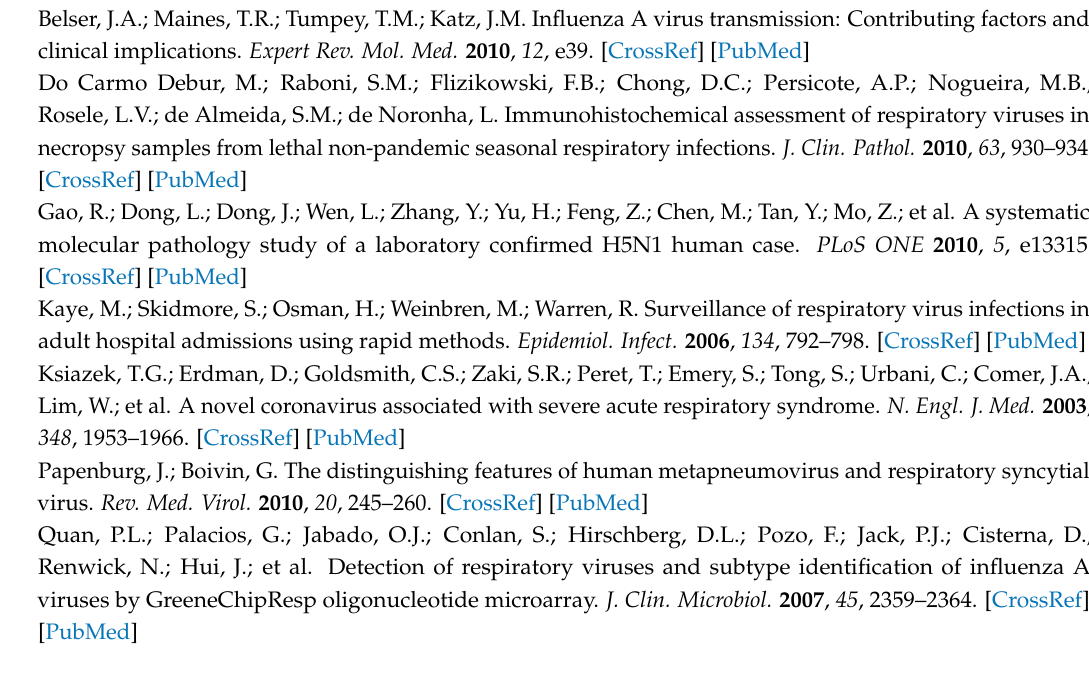
Table S1: Proteomics identification of proteins in murine BAL fluid from MHV-68 infection, Table S2. RT-PCR primers used in this study, Figure S1. Analysis of viral and cellular components in BAL fluid. Figure S2. One of the LC/MS-MS spectra identifying mouse Pdx6. Figure S3. Dynamics of ROS generation in MHV-68 infection of cultured cells. Figure S4. Tnfaip8l2 is a member of a conserved gene family in human and mouse. Author Contributions: E.B., T.-T.W. and R.S. conceived and designed the experiments; E.B. and J.P.W.